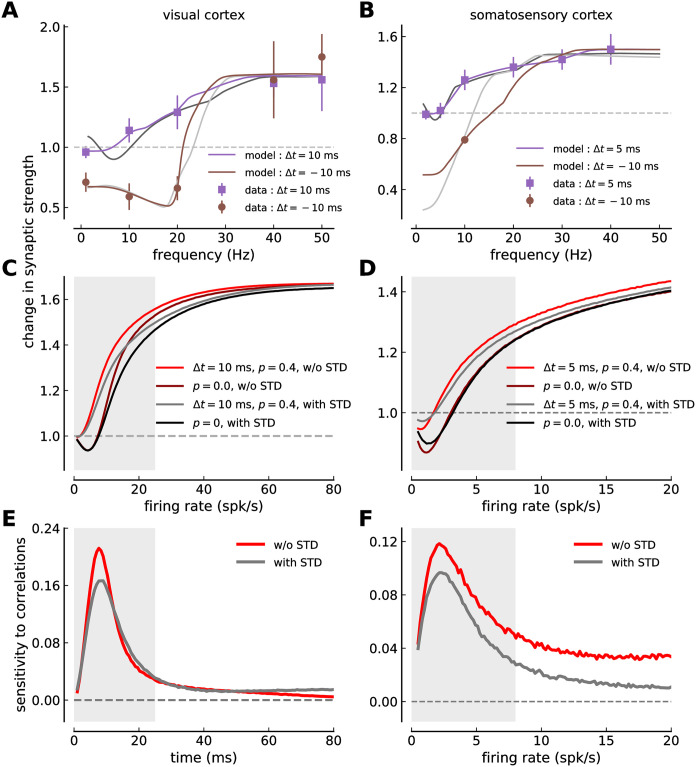
Comparison between model versions with and without short-term depression.(A, B) Model fit (solid lines) to the experimental plasticity data obtained in visual cortex (A, mean ± SEM, [2]) and somatosensory cortex slices (B, mean ± SEM, [3]). Same depiction as in Fig 2. The purple and brown lines show the model without STD fitted to the data, while the gray lines are a reproduction from Fig 2A and 2B of the model with STD. (C, D) Change in synaptic strength in response to irregular pre- and post activity as a function of the firing rate for several values of the correlation coefficient p and one time lag Δt in visual- (C) and somatosensory cortex (D). Two cases are shown for the model without STD: (i) uncorrelated Poisson spike trains (p = 0, dark red) and (ii) pre-post pairs with Δ = 10 ms in C (Δ = 5 ms in D) at p = 0.4 (red). These two cases are also shown for the model with STD: (i) uncorrelated Poisson spike trains shown in black, and (ii) pre-post pairs with Δ = 10 ms in C (Δ = 5 ms in D) at p = 0.4 shown in gray. (E, F) Sensitivity of synaptic changes to spike-pair correlations in visual- (E) and somatosensory cortex (F). The change in synaptic strength due to spike-timing correlations is shown as a function of the firing rate for the model without STD (red) and with STD (gray; same line as in Fig 4C and 4D). Prevalent firing rate ranges in visual (< 25 spk/s; [41]) and somatosensory cortex (< 8 spk/s; [42]) are marked by gray shaded regions in panels C-F. Note the different firing rate ranges shown on the x-axis between the left and the right column of panels C-F. All changes in panels C-F are in response to a stimulation for 10 s.